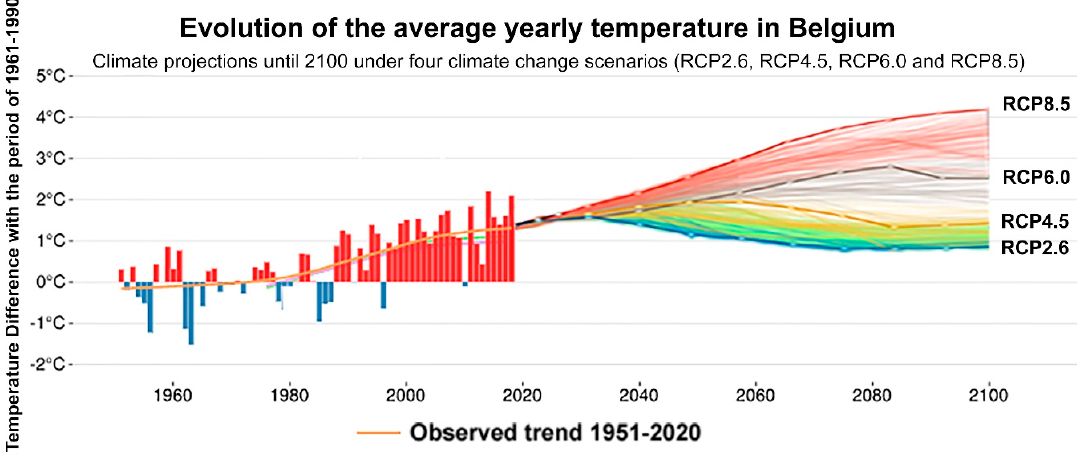
Figure 1. Evolution of the average temperature in Belgium (compared to normal 1961–1990) for the period 1951–2100 (adapted from RMI) [11].